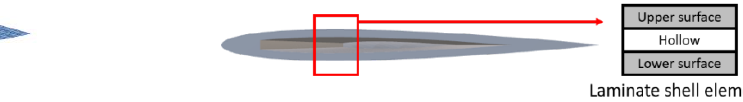
Figure 8. CT scan ( left ) and picture ( right ) of the cross-section of the flutter wing.